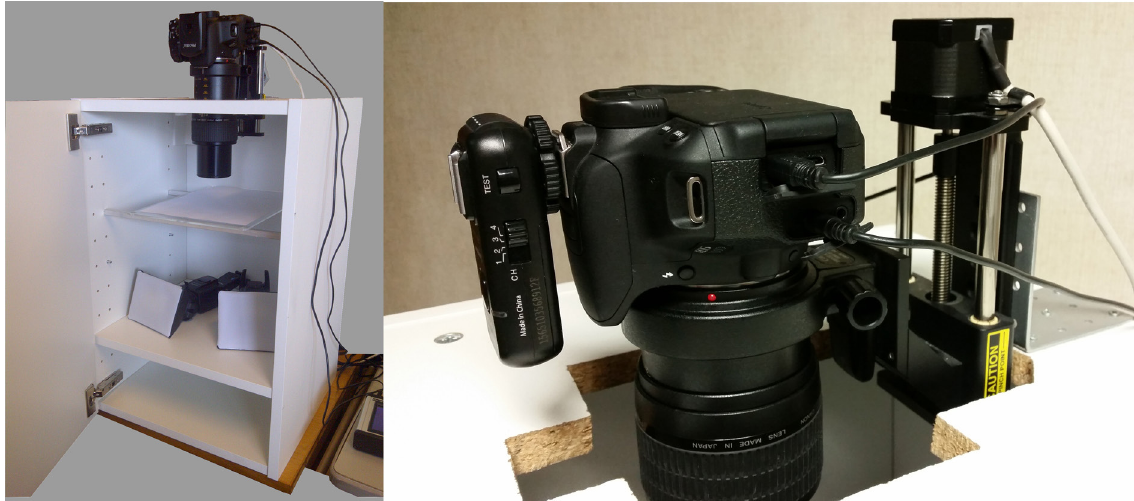
Fig. 2.1. Focus Stacking setup used at the Royal Belgian Institute of Natural Sciences (RBINS) and the Royal Museum for Central Africa (RMCA). Left: View of the complete set-up; Right: Detailed view of the camera mounted to stackshot and to the closet using a metal corner, to mount the camera vertically.